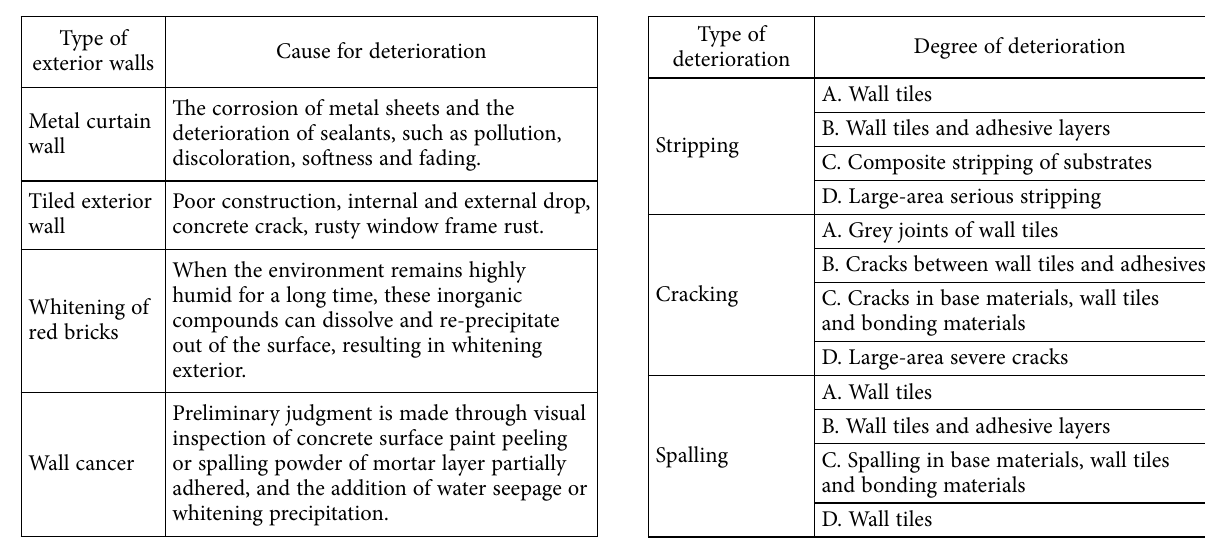
Table 3. Degree of deterioration